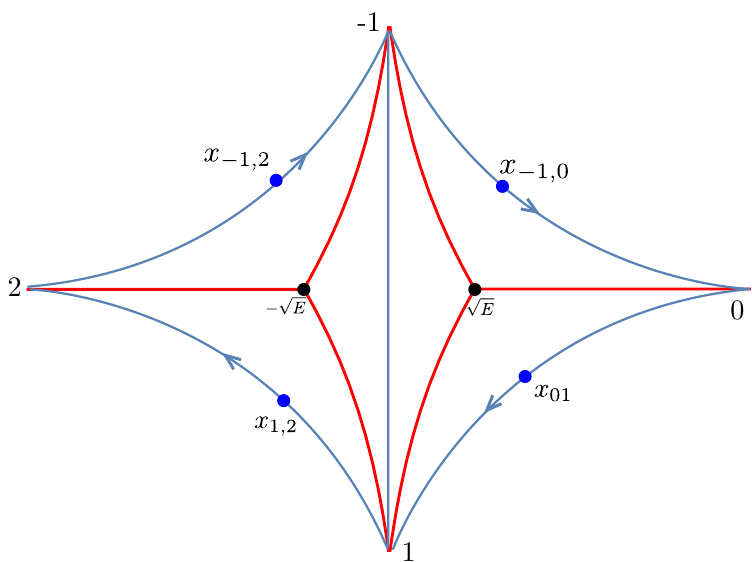
Figure 5 . WKB diagram for the differential equation (B.29). Generic flow lines and WKB lines are colored blue and red